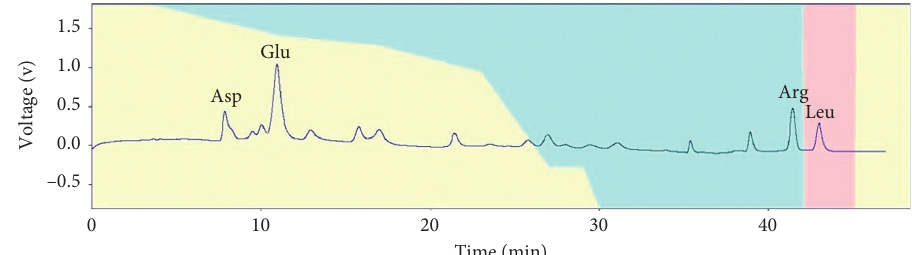
Figure 4: Amino acid profile of the hazelnut by using an amino acid